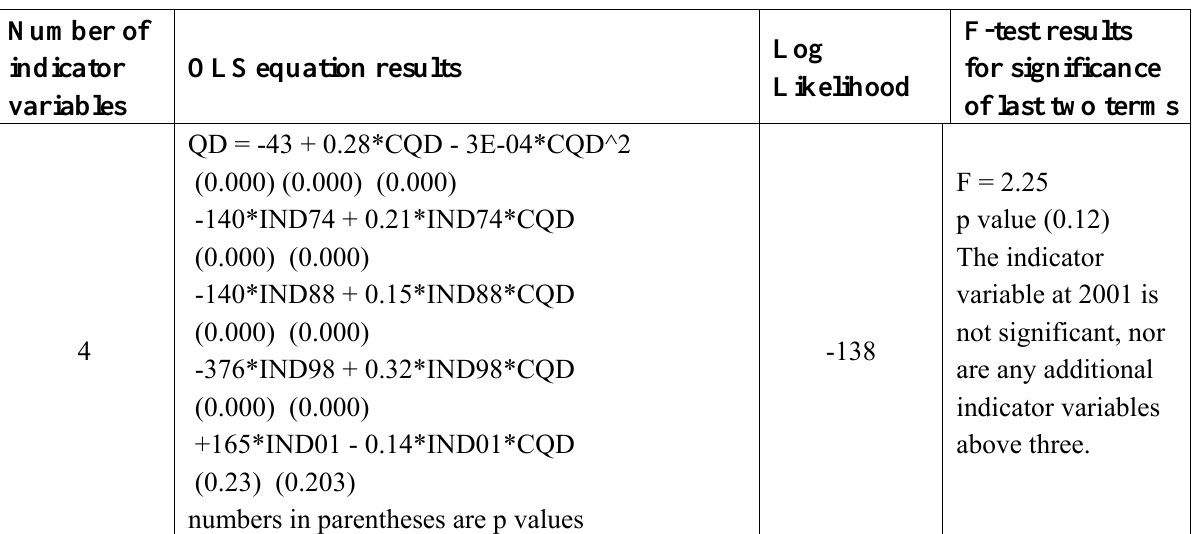
Table 5. Quintuple Hubbert Cycle OLS